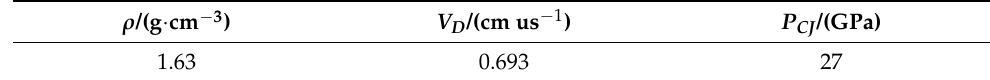
Table 4. Explosive material parameters.